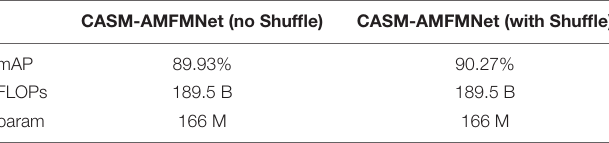
TABLE 9 | Effect of shuffle on the model.